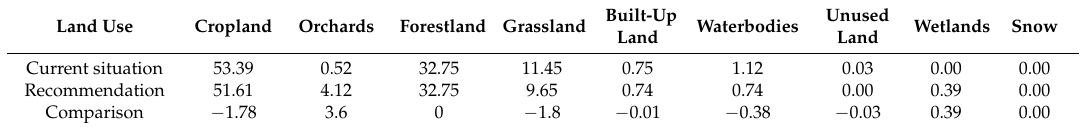
Unused Built-Up Wetlands Snow Waterbodies Land Land